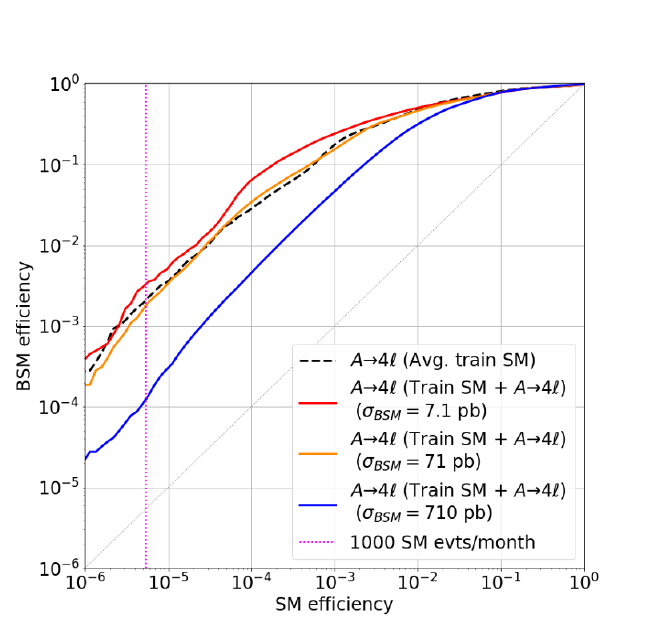
Figure 11 . ROC curves for the VAE trained on SM contaminated with and without A ! 4 (cid:22) contamination. Di(cid:11)erent levels of contamination are reported corresponding to 0 : 02% ( (cid:27) = 7 : 15 pb | equal to the estimated one to have 100 events per month), 0 : 19% ( (cid:27) = 71 : 5 pb) and 1 : 89% ( (cid:27) = 715 pb) of the training